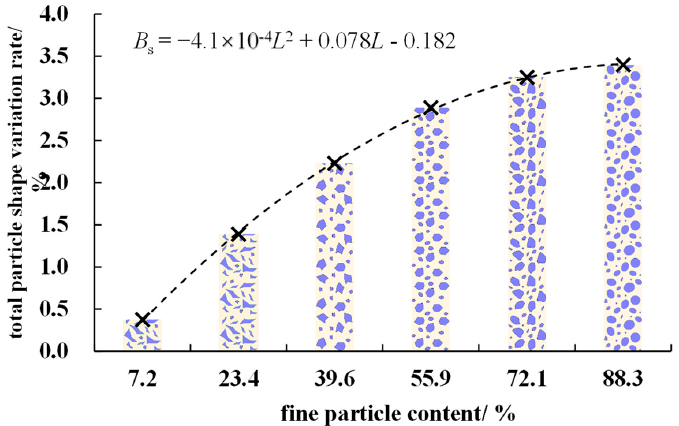
Figure 21. The effect of fine content on the total particle shape.